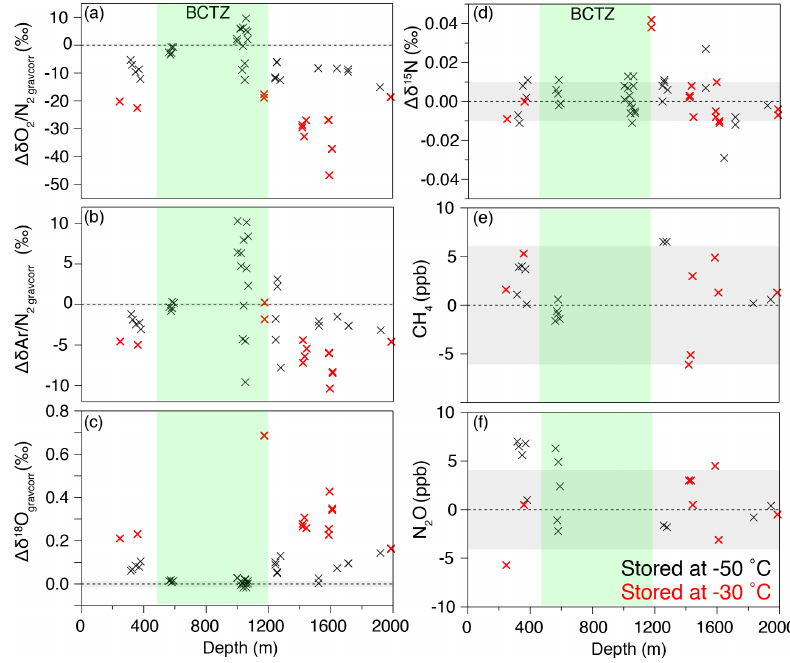
Figure B4. Differences of the values in the outer and inner pieces (outer minus inner) for (a) δ O 2 / N 2gravcorr , (b) δ Ar / N 2gravcorr , Black and red markers show the data using the outer samples stored at − 50 and − 30 ◦ C, respectively.